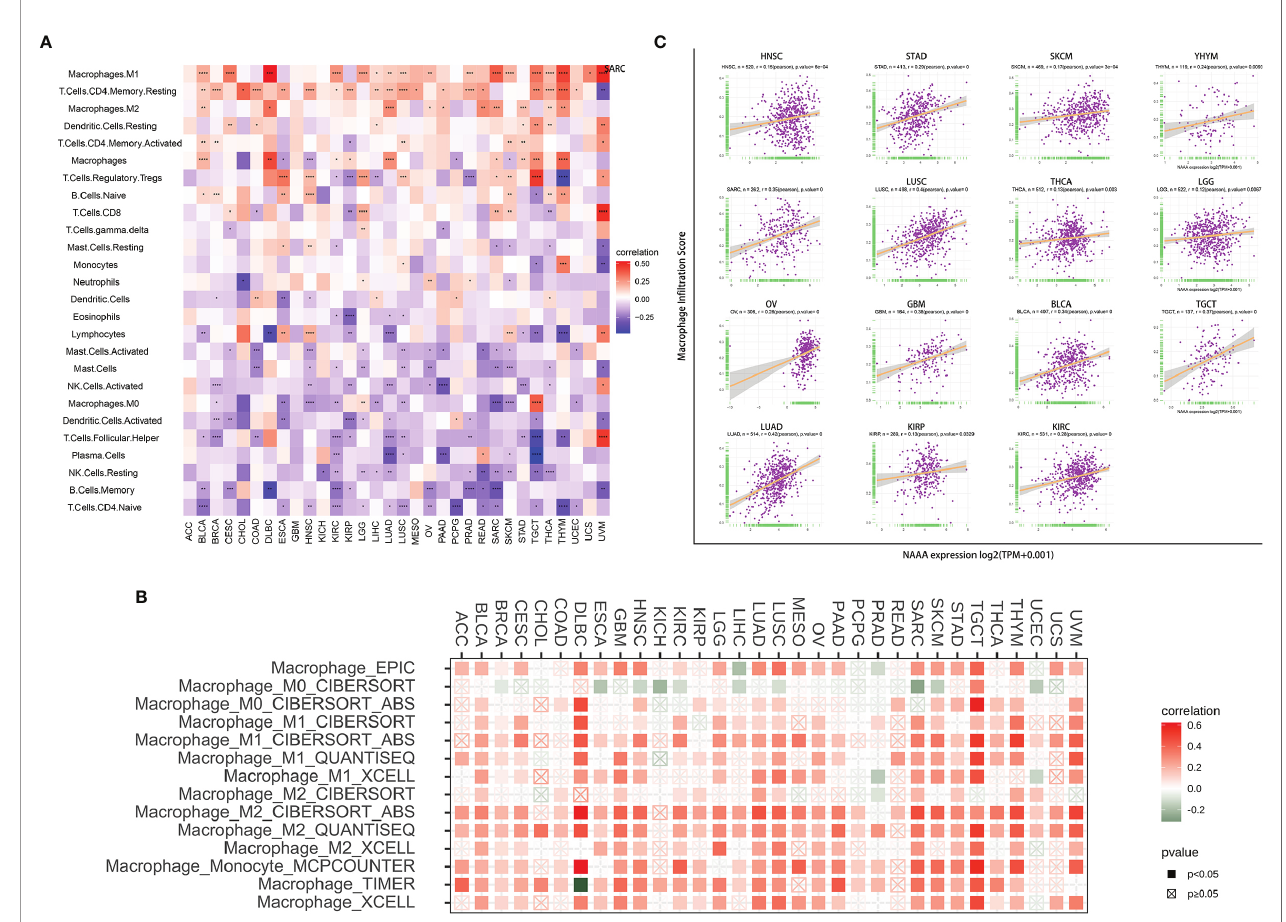
FIGURE 10 | Relationship of NAAA expression with Immune cell in fi ltration analysis. (A) The relationship between NAAA expression levels and the levels of in fi ltration of 26 immune-related cells. (B) The correlation between NAAA expression and TAM in fi ltration levels by using TIMER2 database. (C) The correlation between NAAA expression and TAM in fi ltration by using ImmuCellAI database.